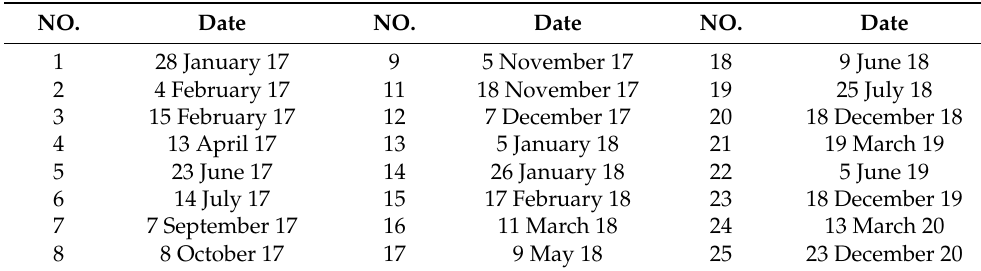
Table 2. Dates of UAV-GNSS campaigns.